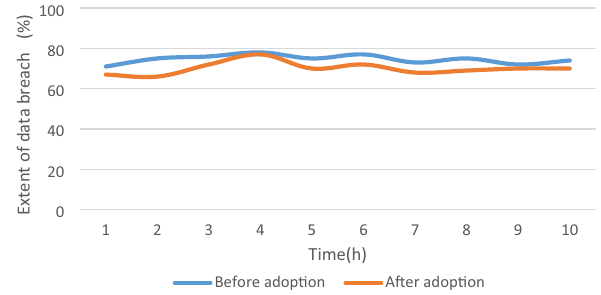
Fig. 9 Hourly data breach comparison